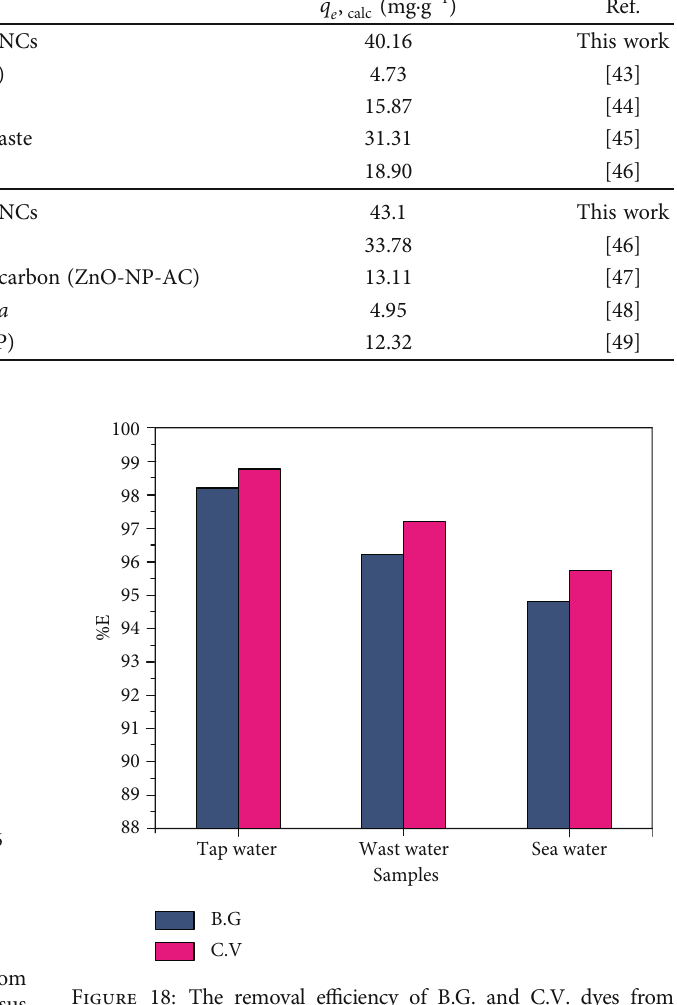
NC solid 2 NCs 2